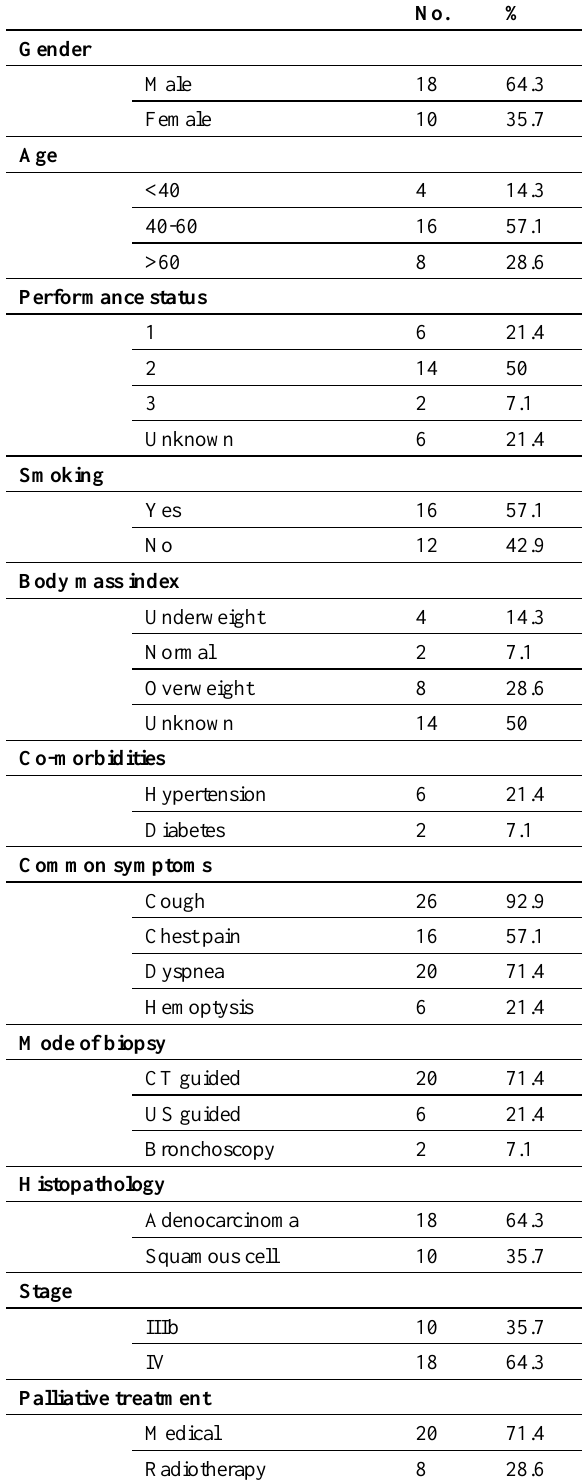
Table 1: Clinico-epidemiological characteristics of 28 patients with stage IIIb-IV NSCLC receiving second-line chemotherapy